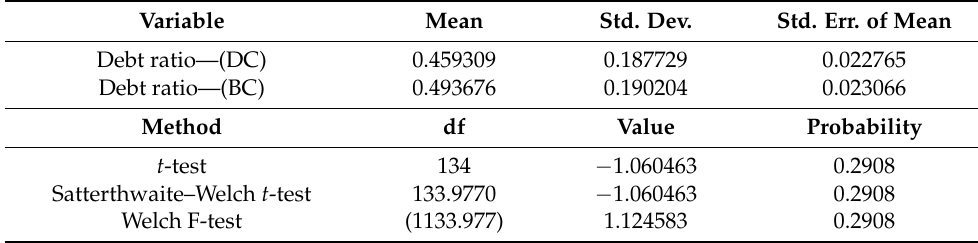
Table 12. The result of the debt ratio. Variable Mean Std.